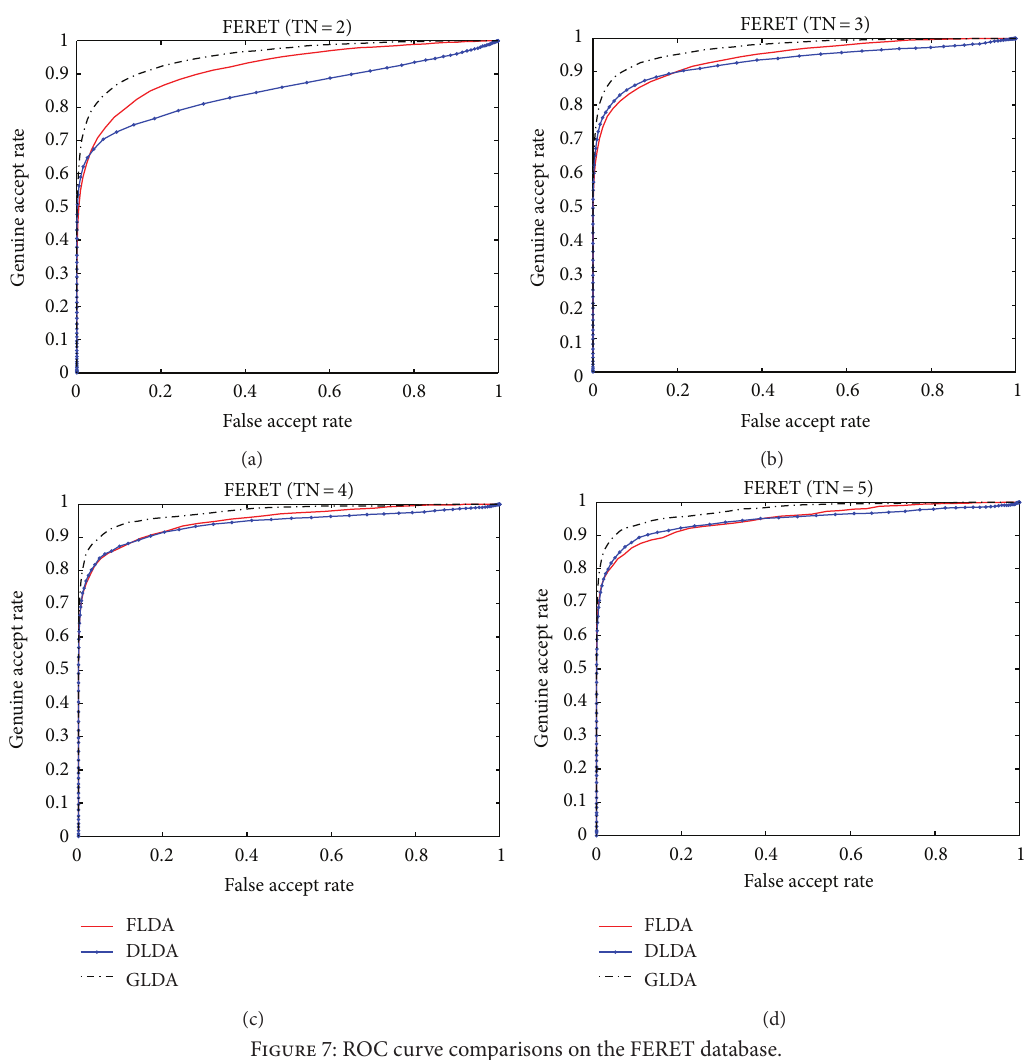
Figure 7: ROC curve comparisons on the FERET